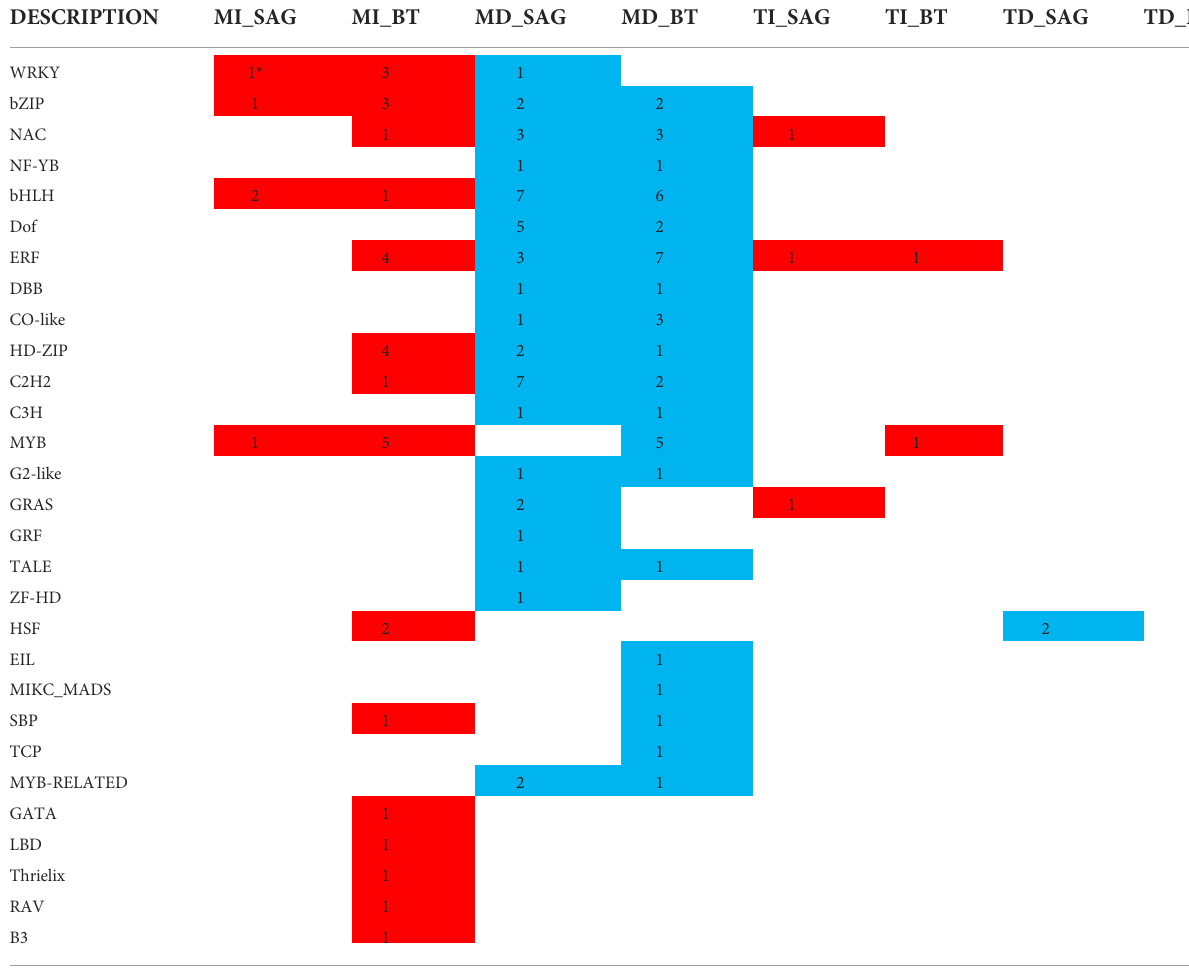
*Number of genes in each family for each expression cluster Red indicates up-regulated and blue indicates